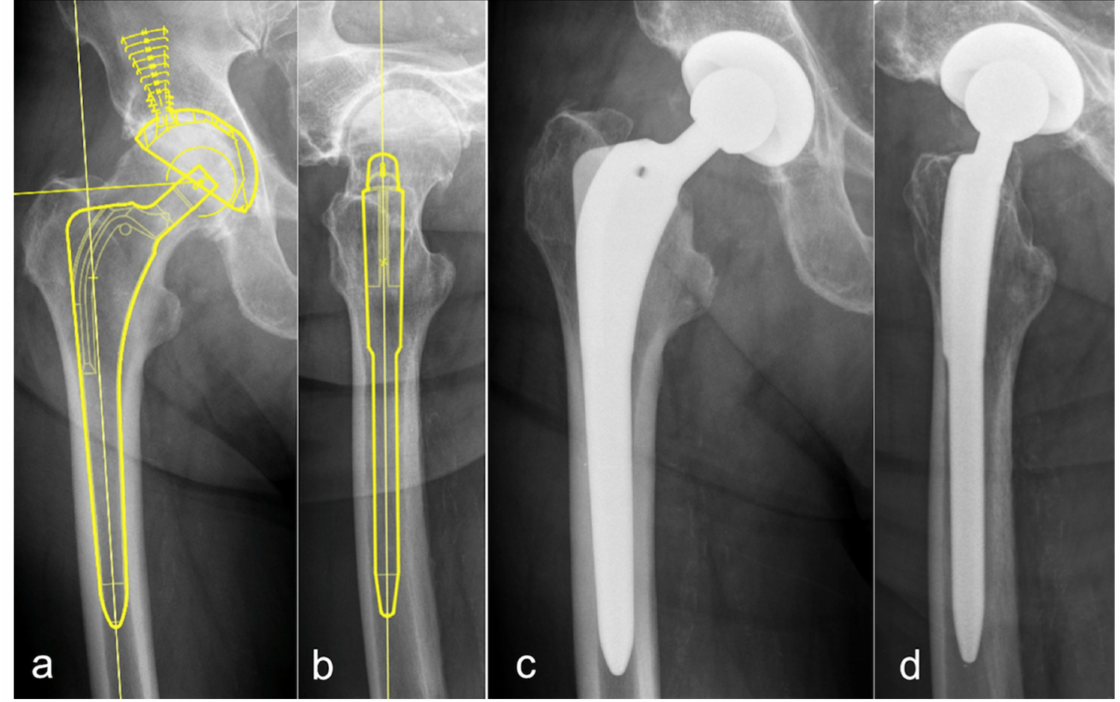
Figure 2. Digital templating of the BICONTACT stem (CTHA) in an anteroposterior ( a ) and lateral ( b ) view with the corresponding postoperative radiographs ( c , d